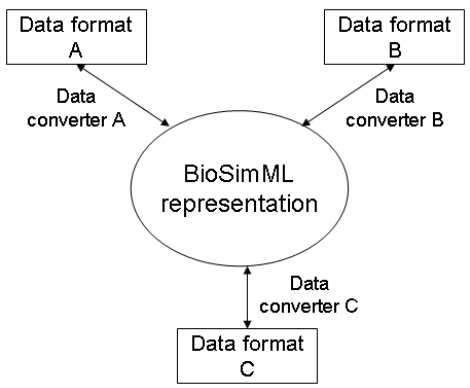
Figure 5: Data conversion between di ff erent data formats based on the BioSimML